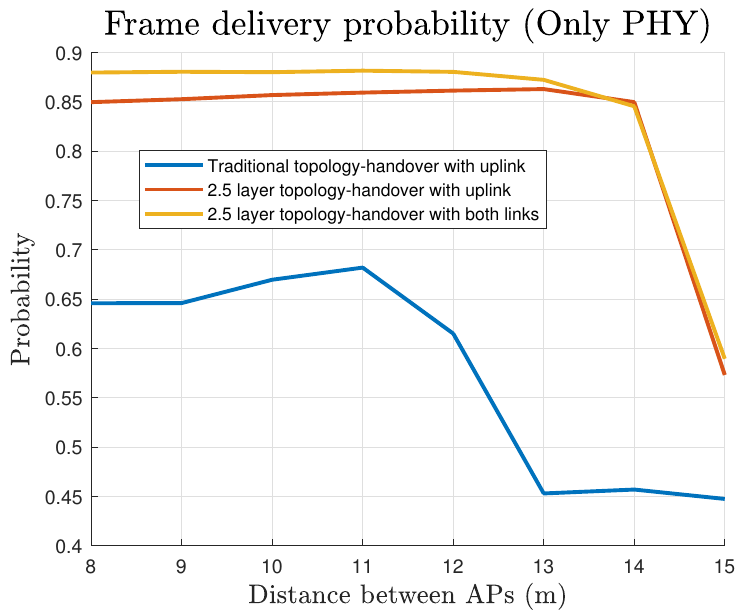
Figure 19. Physical layer Frame Error Rate (logarithmic scale).